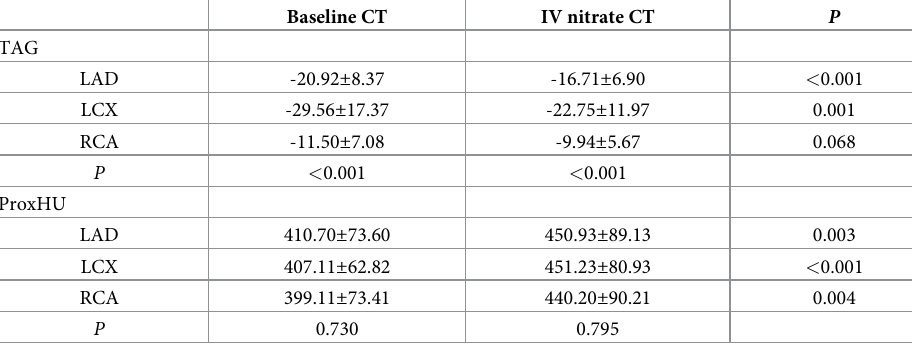
Table 3. TAG and ProxHU values for the vessel types on baseline CT and IV nitrate